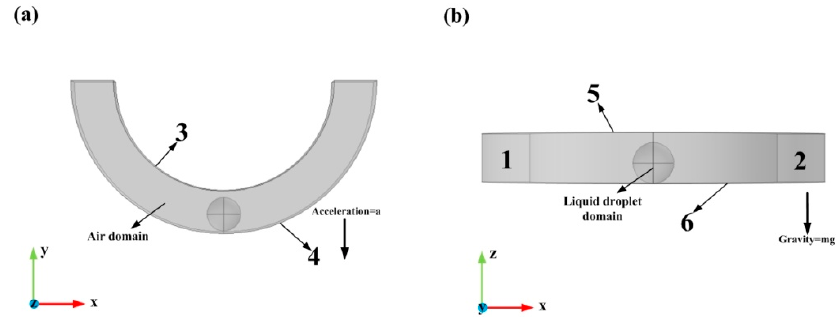
Figure 3. 3D model, initial, and boundary condition of the liquid droplet domain and the air domain: ( a ) is the top view of the model; ( b ) is the front view of the model.